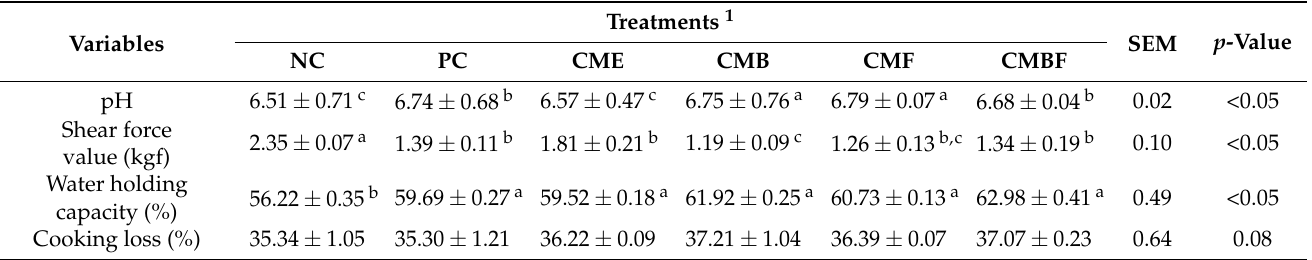
Table 4. The quality characteristics of the breast meat of Korean ginseng chicken soup that was hydrolyzed with Cordyceps militaris mushroom